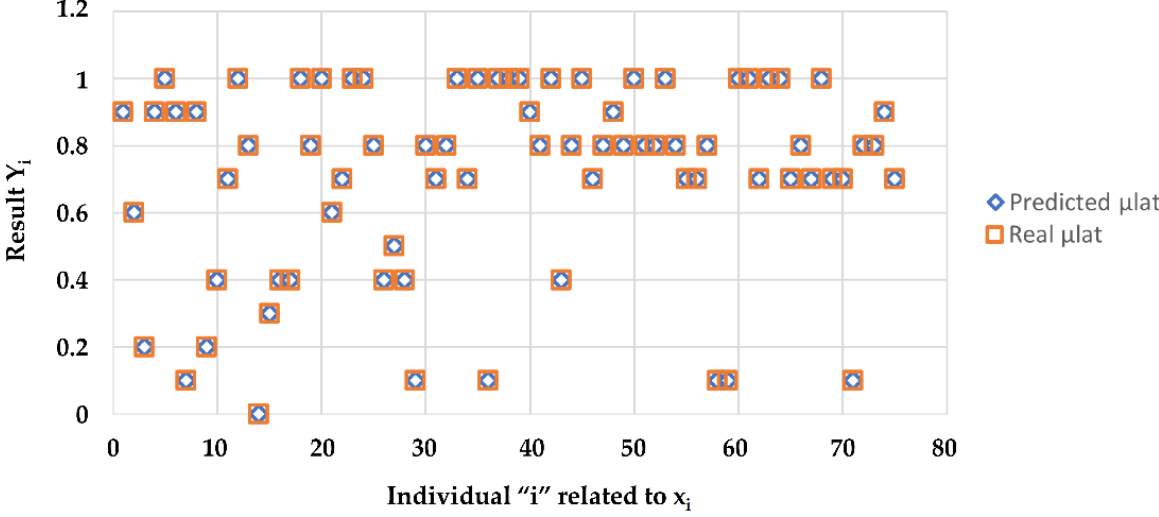
Figure 5. Coefficient μ lat : predicted v/s real values.